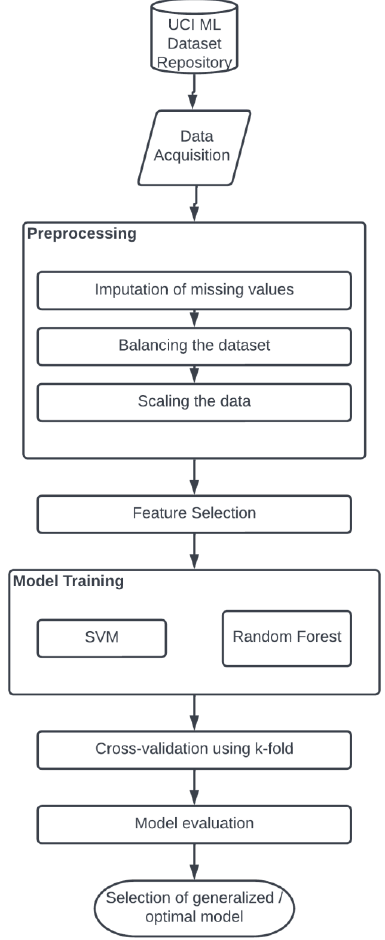
Figure 1. Block diagram of the proposed